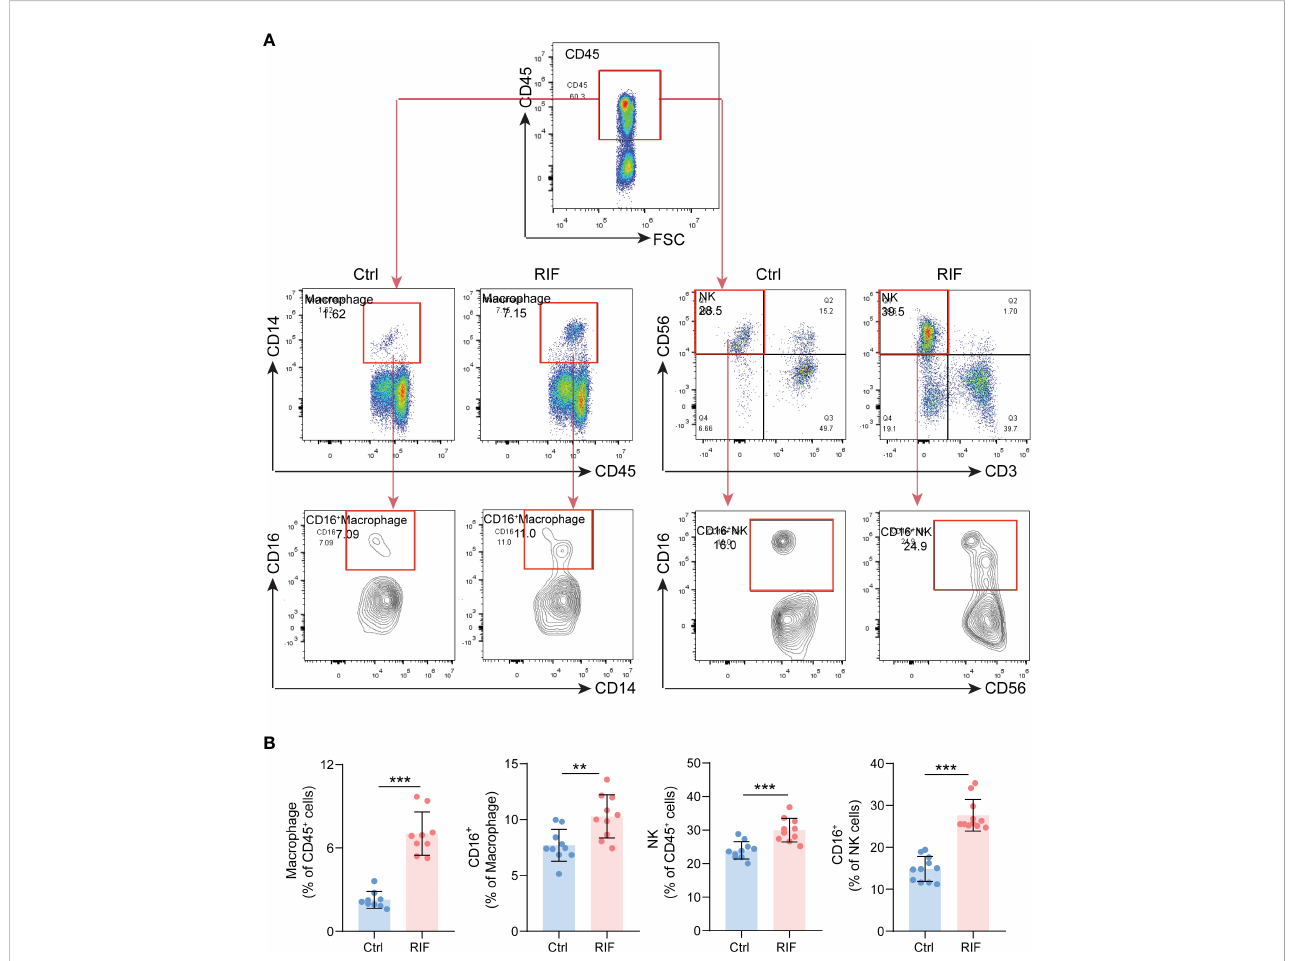
FIGURE 6 The Proportions of Macrophage and NK Cells. (A) The gating strategy for identifying macrophage and NK cells from endometrial leukocytes. (B) The quantitative analysis of the proportions of macrophage, NK cells, CD16 + macrophage and CD16 + NK cells (n=10) in endometrium from control and RIF patients. Data are presented as the mean ± standard error of the mean. Statistical signi fi cance (Student ’ s t-test): **p < 0.01, ***p <